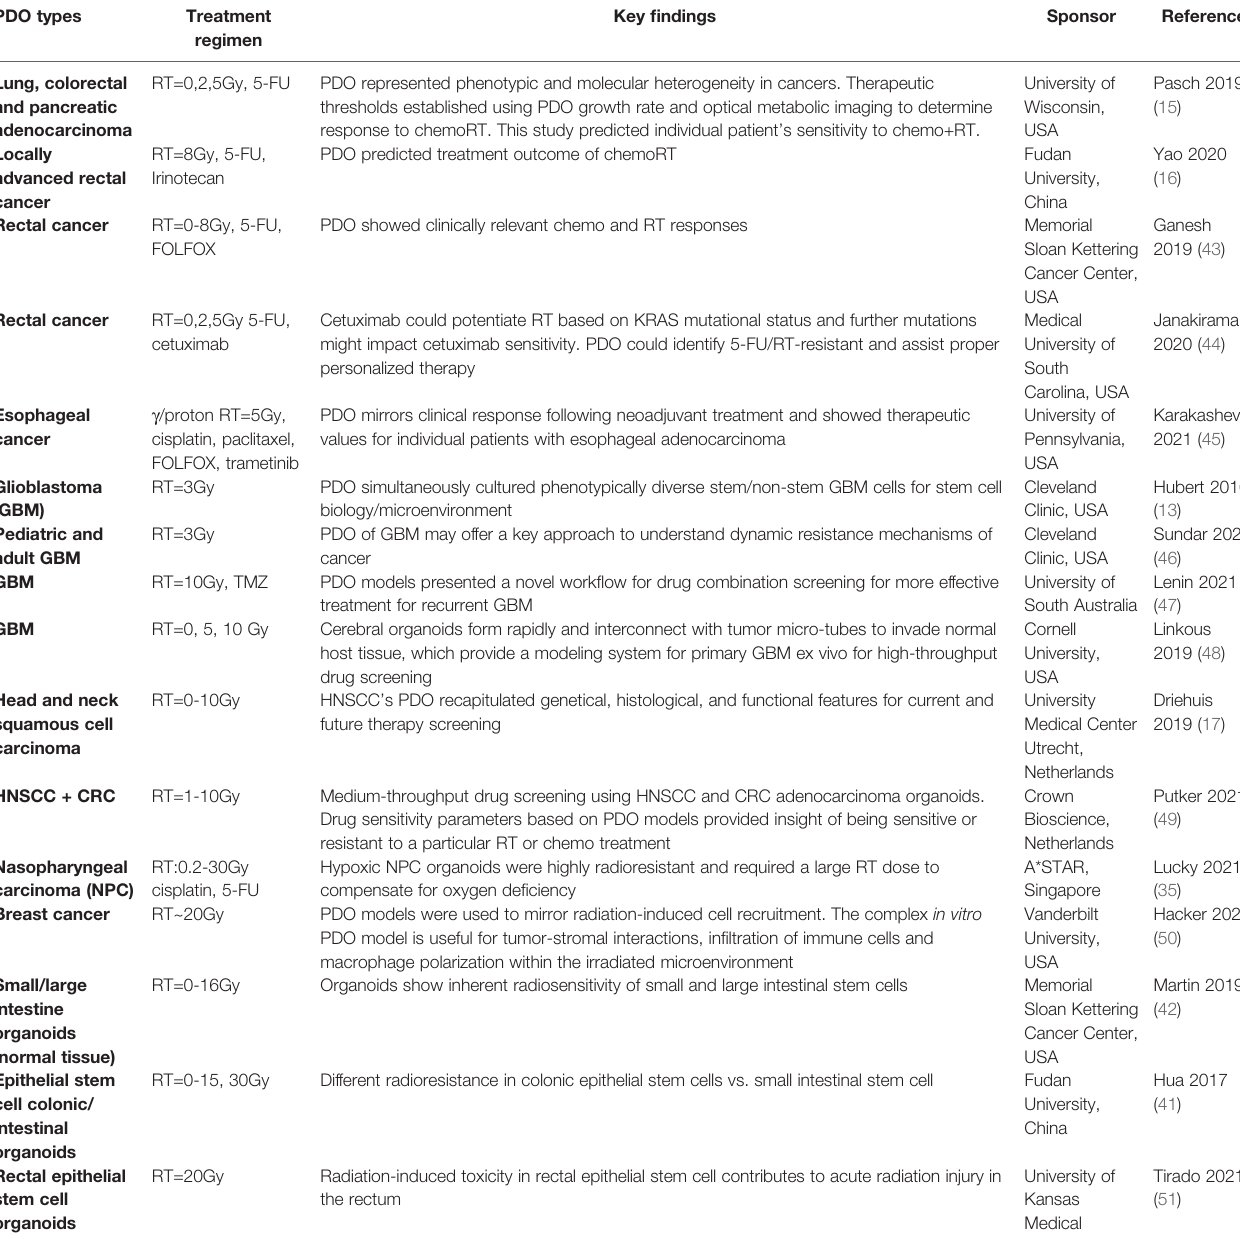
TABLE 1 | Summary of PDO cancer models or normal tissue models undergoing